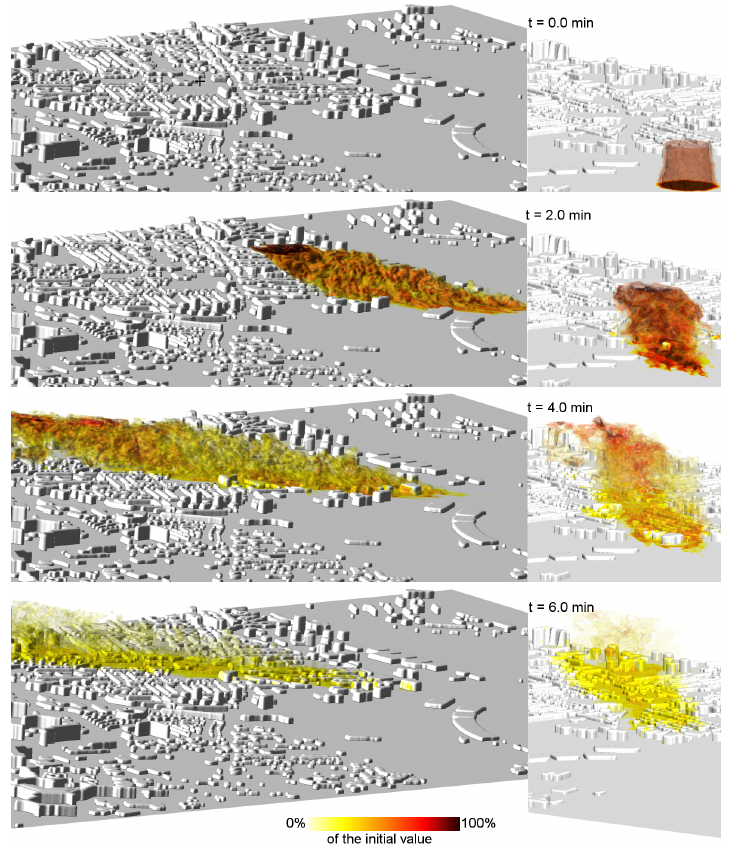
Figure 6. Four visualisations of the plume dispersion for the C4/C2-R3 simulation from the initial stage (top) until 6 min after the emission (bottom) with two view angles (left and right). The colour code indicates the ratio of pollutant concentration to the initial value (in %) with dark brown/black corresponding to the initial concentration. The ground and the buildings appear in grey. At t = 6 min, the plume presents a length of 2 km and a width of 500